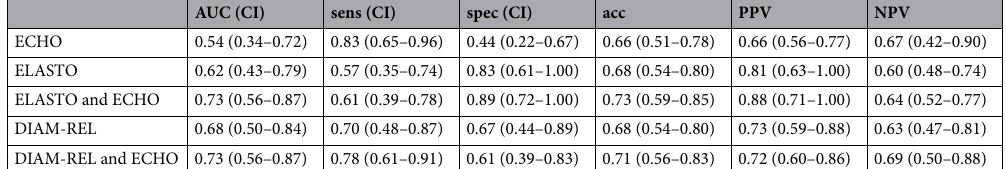
Table 5. Evaluation of selected classifiers of responding tumours (RMC ≤ 30%) after third NAC course. Evaluation parameters are given with the 95% confidence level (95% CL). Sens sensitivity, spec specificity, acc accuracy, PPV positive predictive value, NPV negative predictive